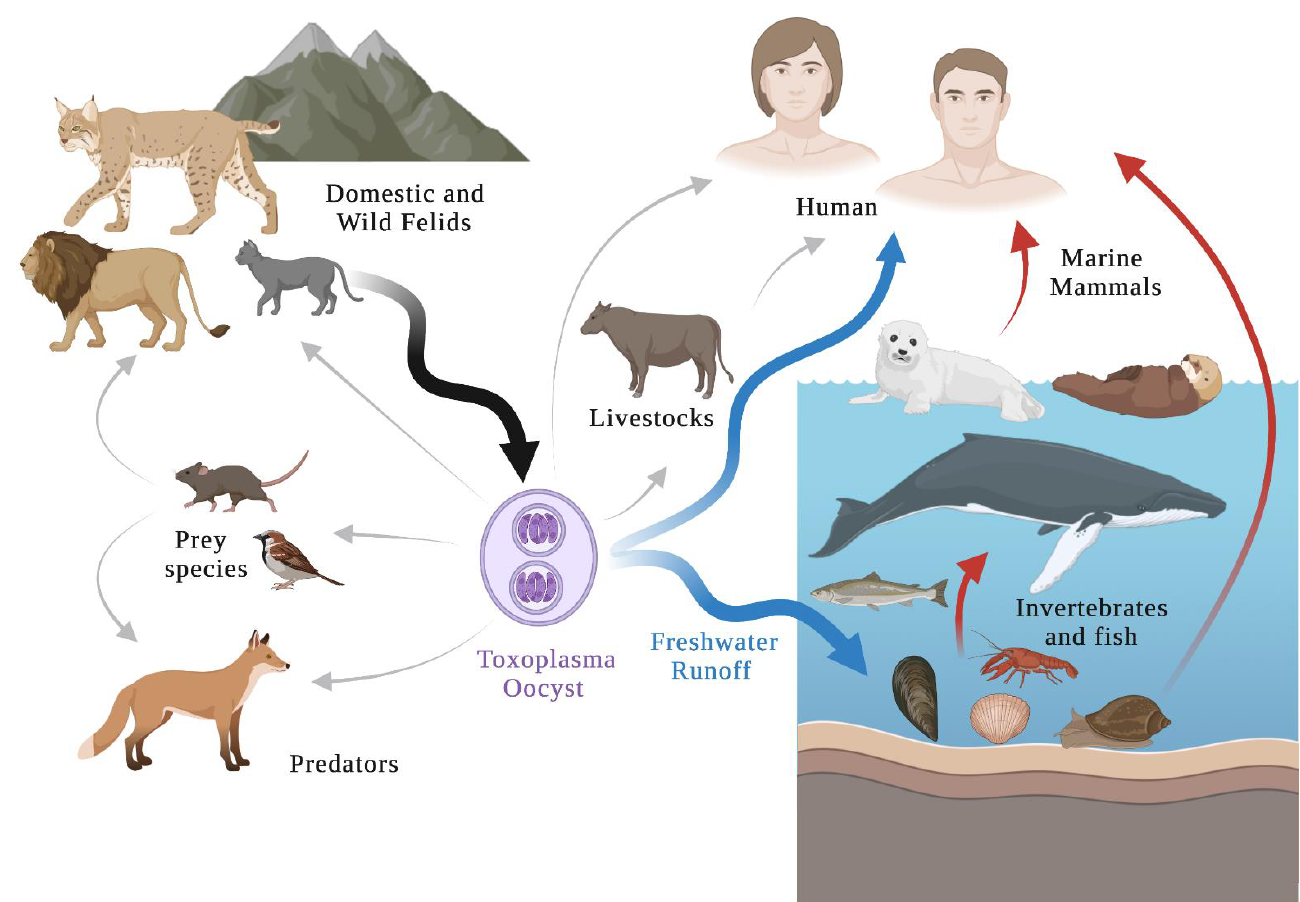
Figure 3. A route of T. gondii oocyst-induced transmission. Domestic and wild felids are the only known source (black arrow) of T. gondii oocysts. The environmental resistant oocysts can be trans- ported in freshwater runoff (blue arrow). The possible infection routes of terrestrial (gray arrows) and marine species (gray arrows) may be exposed directly to oocysts or indirectly through food sources. Schematic based mainly on https://counterbite.wordpress.com/2019/09/28/cats-and-the- ecosystem/, accessed on December 2021.